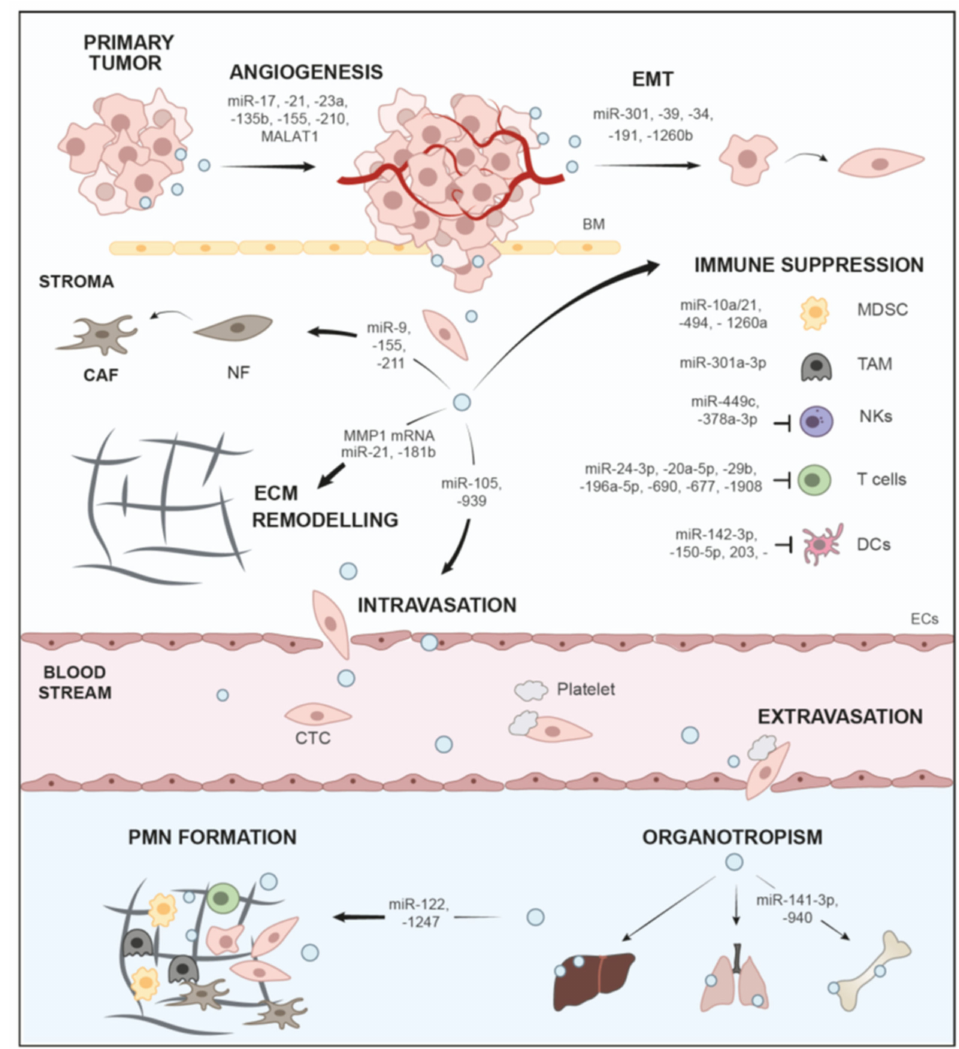
Figure 2. Functions of sEVs and ncRNA cargos in the metastatic